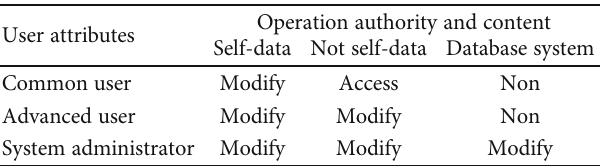
Figure 3: Date structure of intelligent design system for mine tunnel blasting based on Table 1: User permission design.